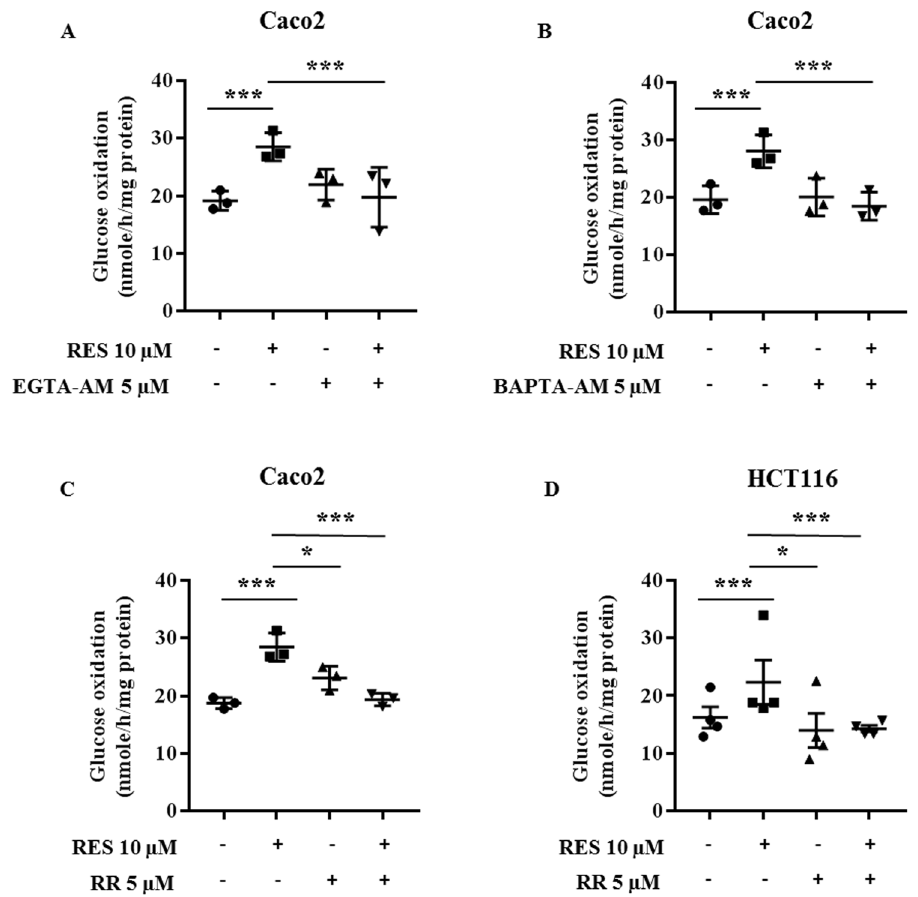
Figure 8. Metabolic effects of resveratrol on glucose metabolism are related to a modulation of calcium flux in colon cancer cells. Subconfluent colon cancer cells were treated with 5 µ M EGTA-AM ( A , n = 3), 5 µ M BAPTA-AM ( B , n = 3) or 5 µ M Ruthenium Red ( C , n = 3; D , n = 4), 1 hour before and during a 48 hour- treatment with 10 µ M resveratrol (RES). Cells were isolated and 10 6 cells were incubated in Krebs-Ringer phosphate buffer supplemented with 5 mM [U 14 C]-glucose (isotopic dilution 1/1000). 14 CO 2 was recovered as described in the Material and Methods section.